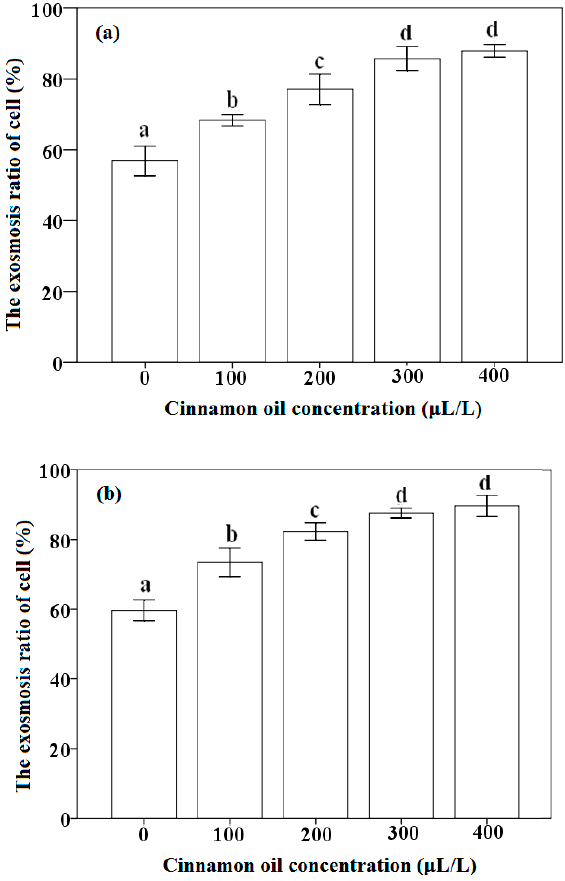
Figure 7. Effect of the concentration of cinnamon oil on the exosmosis ratio of: P. citrinum ( a ); and A. flavus ( b ). Mean bars with different letters (a–d) differ significantly at p < 0.05.